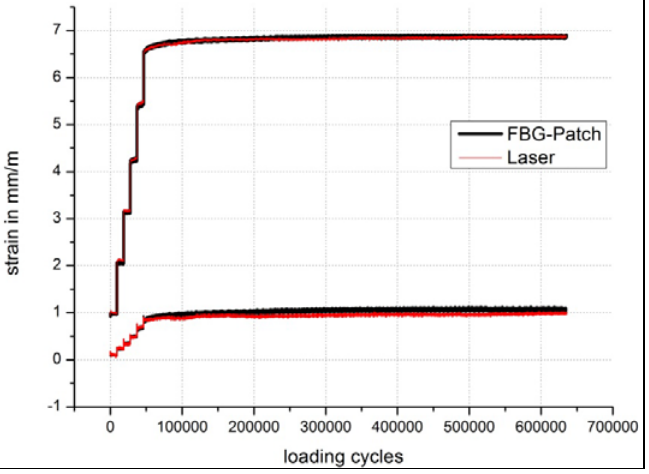
Figure 16. Dynamic fatigue test of a FBG patch referenced with laser